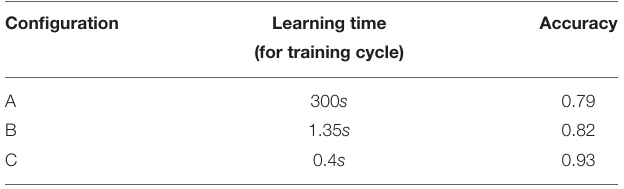
TABLE 4 | Comparison of one-versus-all (OvA) performance obtained with the three structures implemented. Configuration